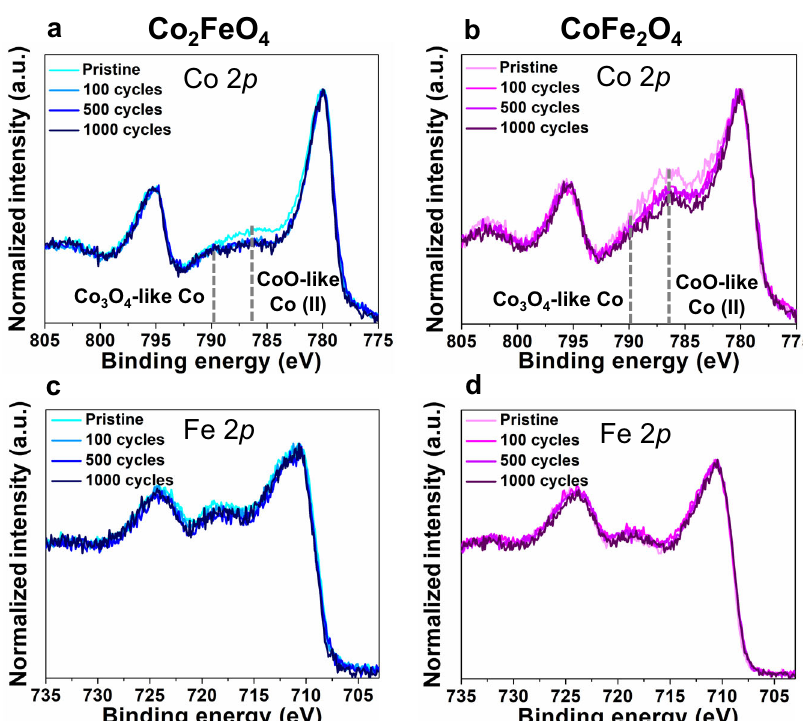
Fig. 2 Surface oxidation state of Co 2 FeO 4 and CoFe 2 O 4 during OER. X-ray photoelectron spectra of a , b Co 2 p and c , d Fe 2 p levels of Co 2 FeO 4 and CoFe 2 O 4 in the pristine state and after 100, 500 and 1000 cycles. The dashed lines indicate the satellite features of Co 3 O 4 -like Co (II, III) and CoO-like Co(II). Source data are provided as a Source Data fi